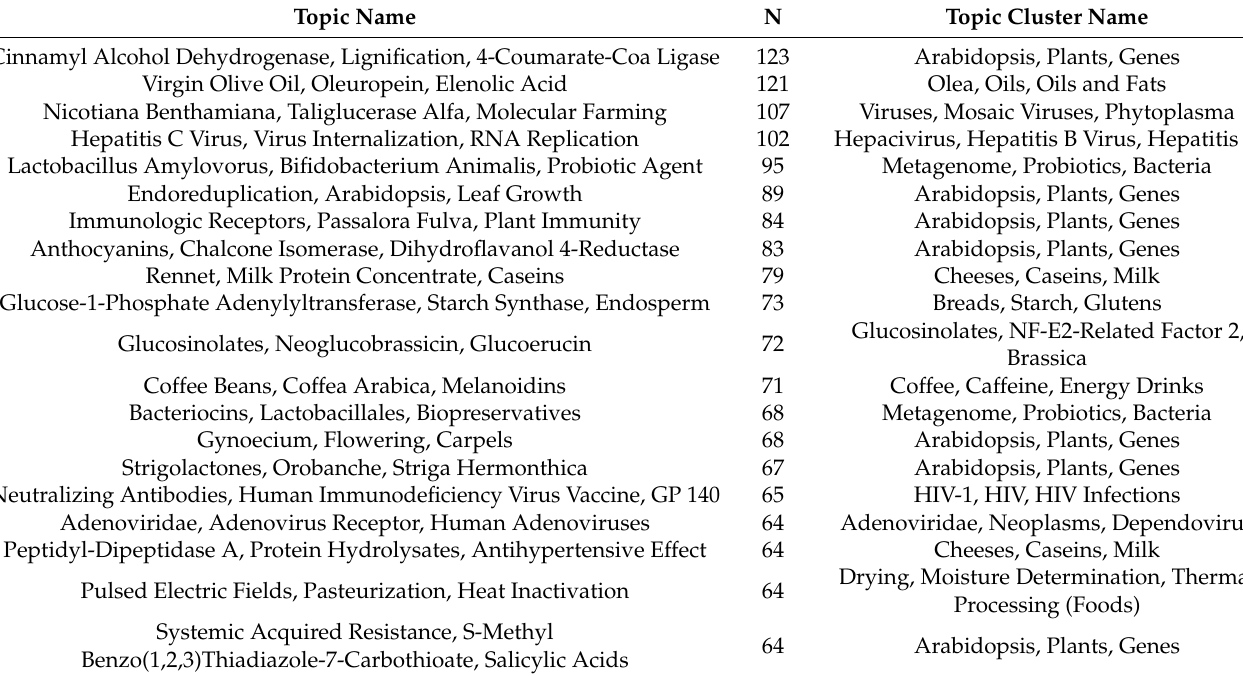
Table 4. Top 20 Topic